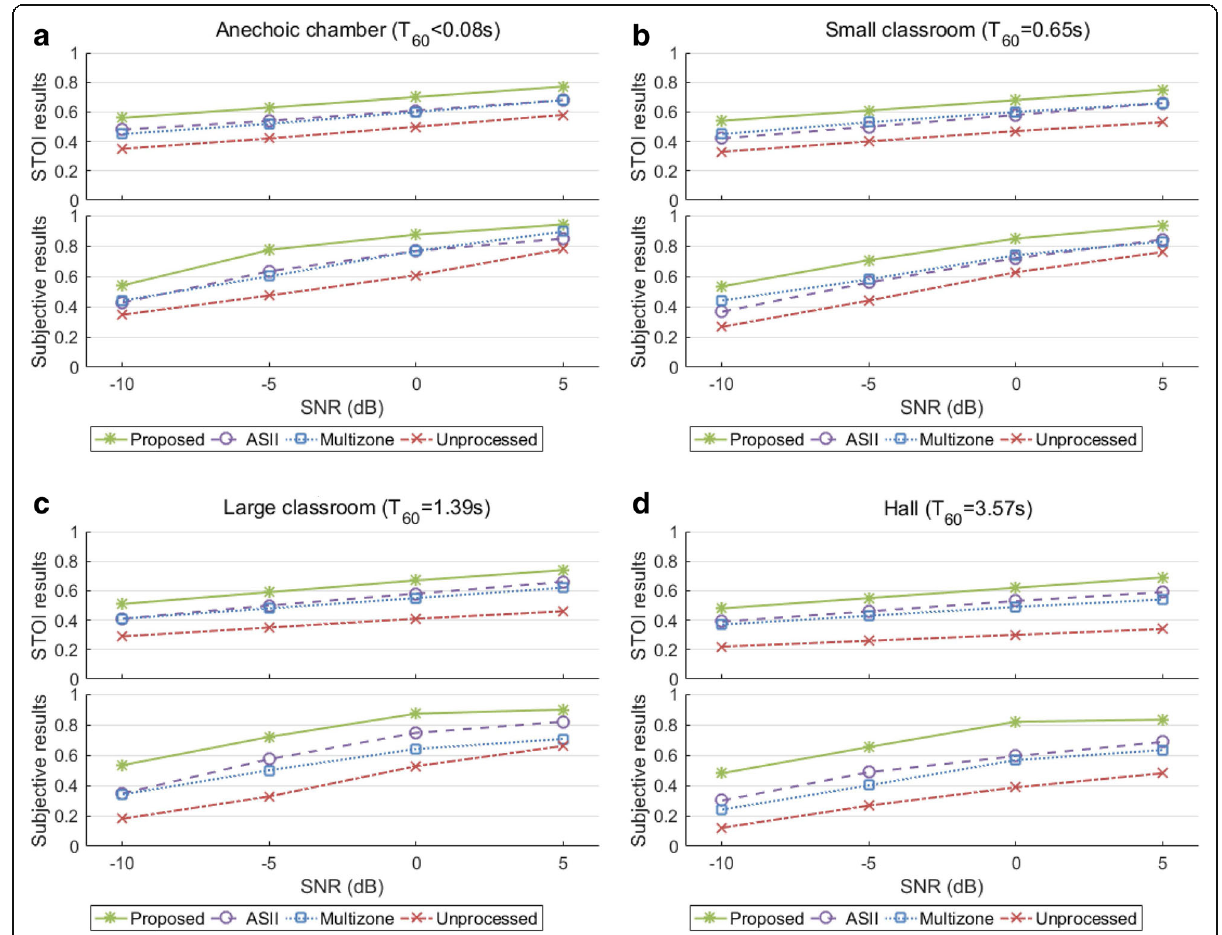
Fig. 8 Comparison results of objective prediction and subjective evaluation. a anechoic chamber ( T 60 = 0.08s), b small classroom ( T 60 = 0.65s), c large classroom ( T 60 = 1.39s), d hall T 60 =